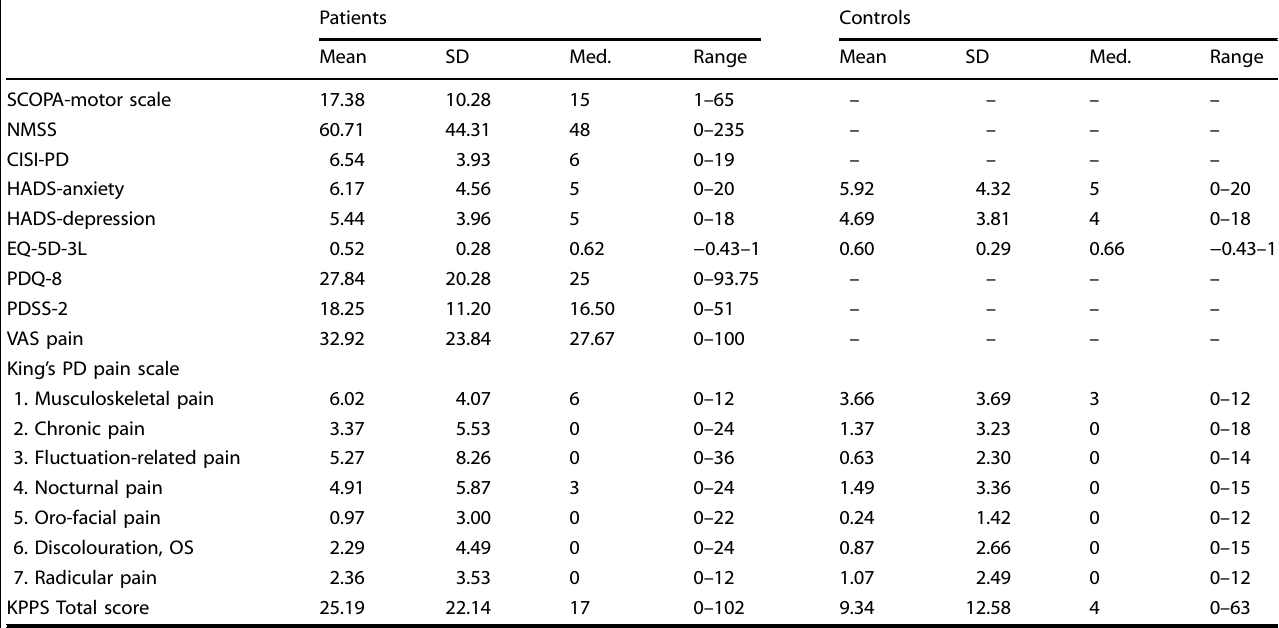
Table 1. Descriptive statistics of the assessments in the